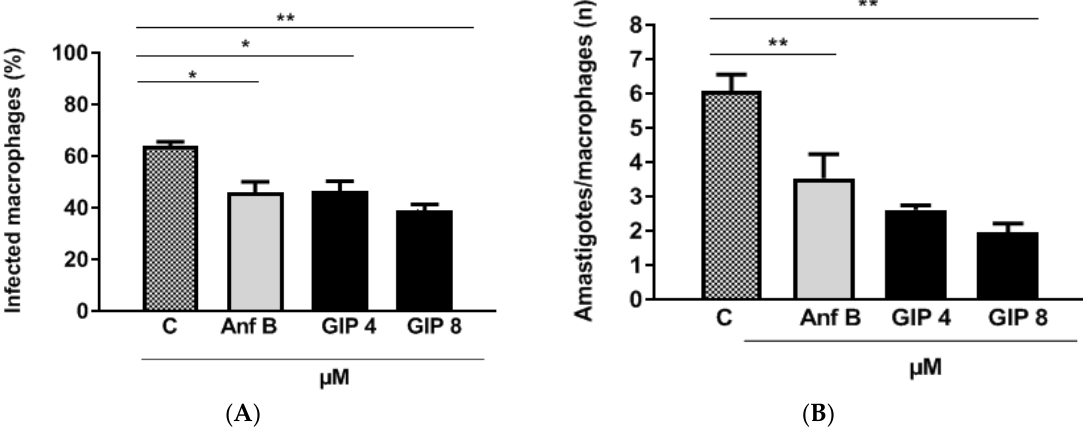
Figure 4. Murine macrophages experimentally infected by L. major without treatment ( A – C ) and treated with IPG at concentrations of 19 μM ( D – F ) and 38 μM ( G – I ). Amphotericin B was used as a positive control at the concentration of 2.16 μM ( J – L ). VP — Parasitophorous vacuole. Black arrows indicate internalized amastigote forms. Red arrows indicate smeared macrophages. Magnification 1000×.